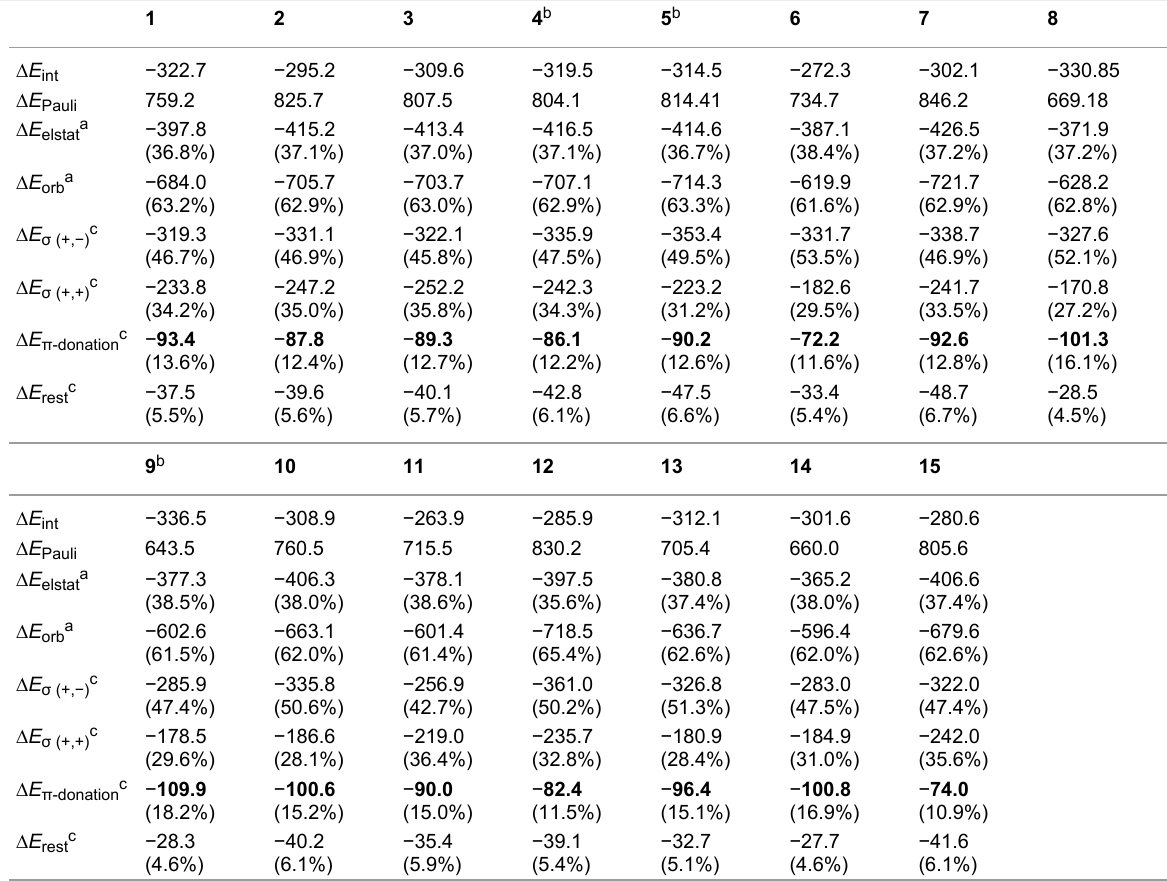
Table 2: EDA-NOCV calculations at the BP86/TZ2P+ level of theory of compounds 1–15 using C(II) in the valence configuration 2s 2 2p σ 1 2p ||1 2p and the remaining fragment as interacting moieties a . Energy values are given in kcal/mol.